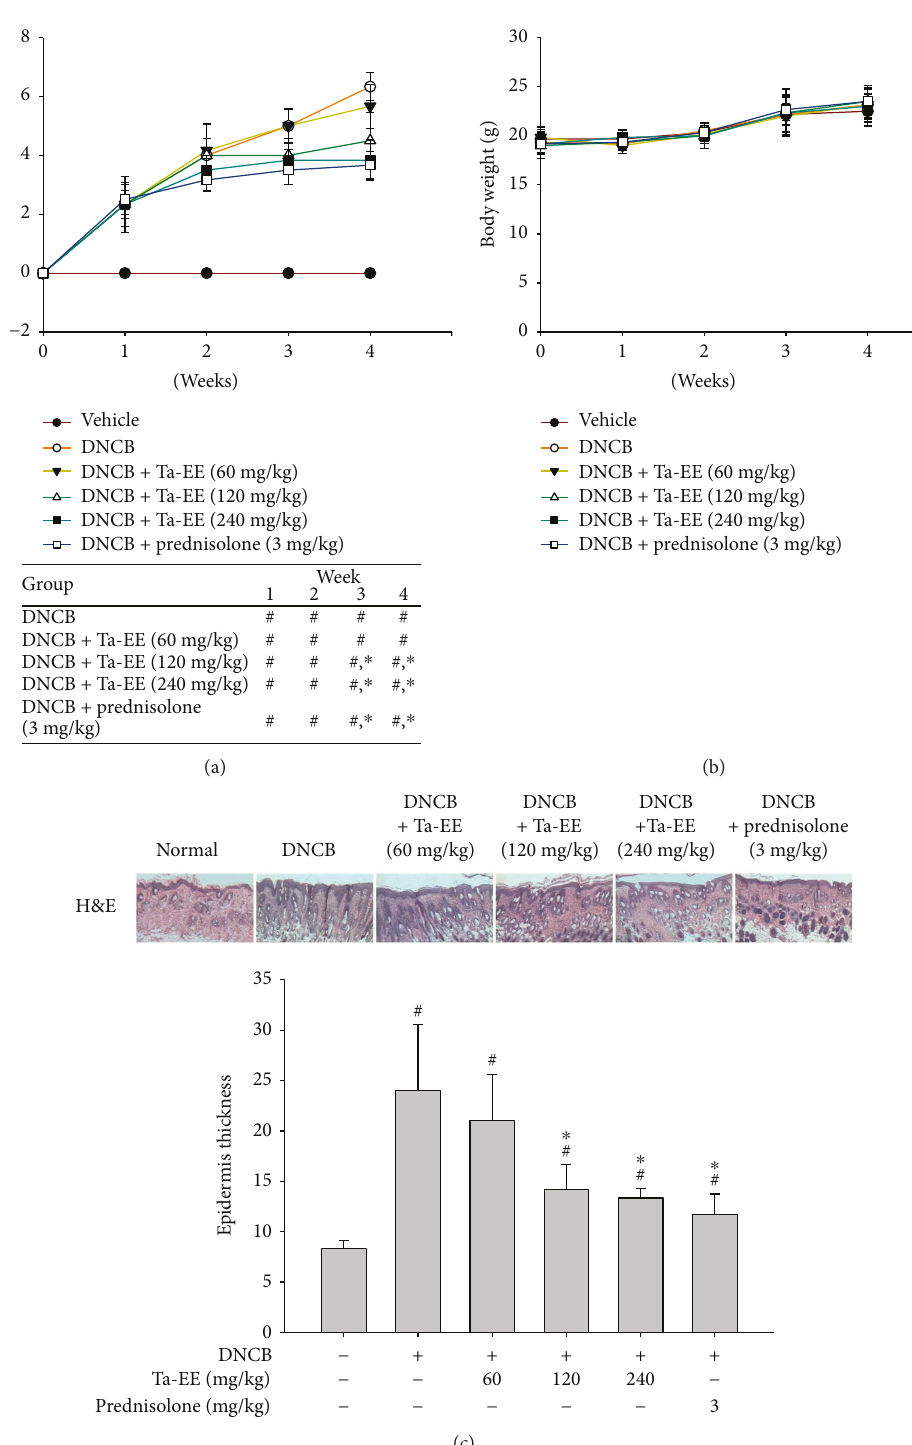
Figure 1: Ta-EE protected against AD symptoms in DNCB-induced AD mice. DNCB-induced AD mice were orally administered with either Ta-EE (0, 60, 120, and 240 mg/kg) or prednisolone (3 mg/kg) once a day for 4 weeks. (a) Dermatitis scores and (b) body weight of the AD mice were determined once a week from week 0 to week 4. ((c), upper panel) DNCB-induced AD mice were orally administered with either Ta-EE (0, 60, 120, and 240mg/kg) or prednisolone (3 mg/kg) once a day for 4 weeks. The atopic dermatitis skin was excised from the AD mice after the animals were sacri fi ced at week 4. The atopic dermatitis skin lesions were stained with H&E. ((c), lower panel) The epidermal thickness of these AD mice was measured and plotted using ImageJ software. ∗ P < 0 05 versus a control group; # P < 0 05 versus a normal